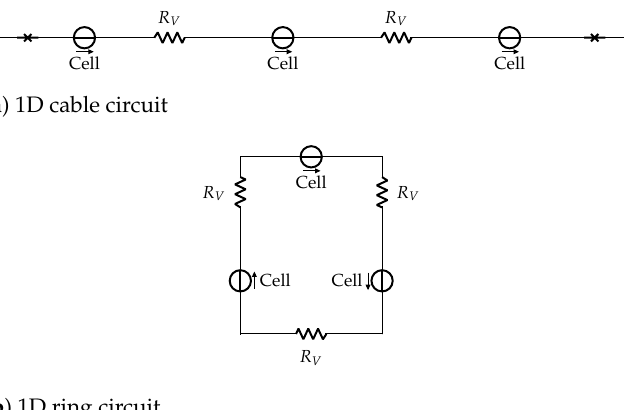
Figure 2. 1D cell structures circuit schematic. Panel ( a ) sketches a cable and Panel ( b ) a ring with 3 cells each. Cells are represented as voltage source and the resistors in between represent the membrane